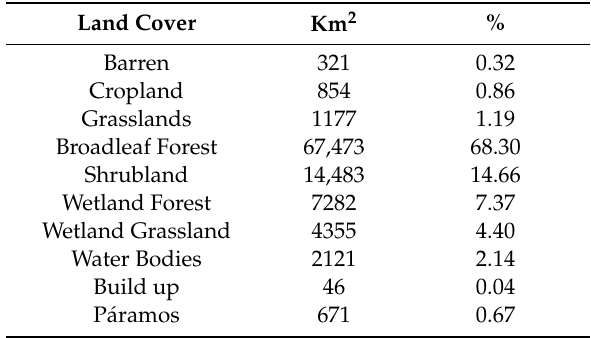
Table 4. Land cover extent using IGBP classes of the Pacific coast of